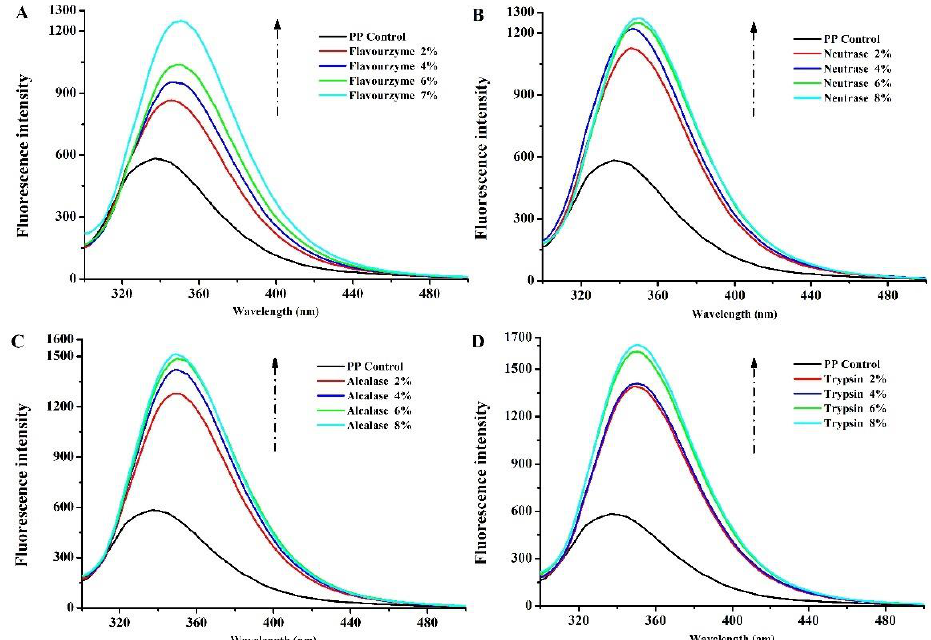
Figure 2. Intrinsic fluorescence of PP and PP with different DH samples (( A – D ) are flavourzyme, neutrase, alcalase and trypsin treatment, respectively).